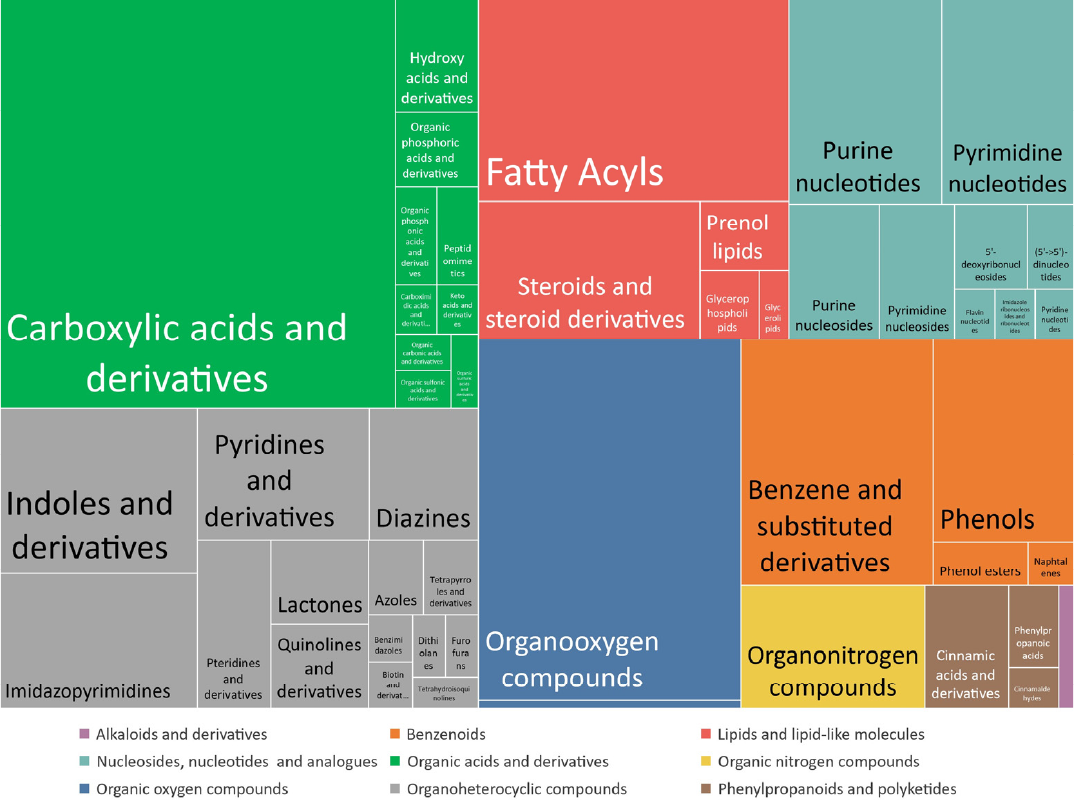
Figure 2. Chemical taxonomy of metabolites included in the targeted library and proportion of each superclass and class.